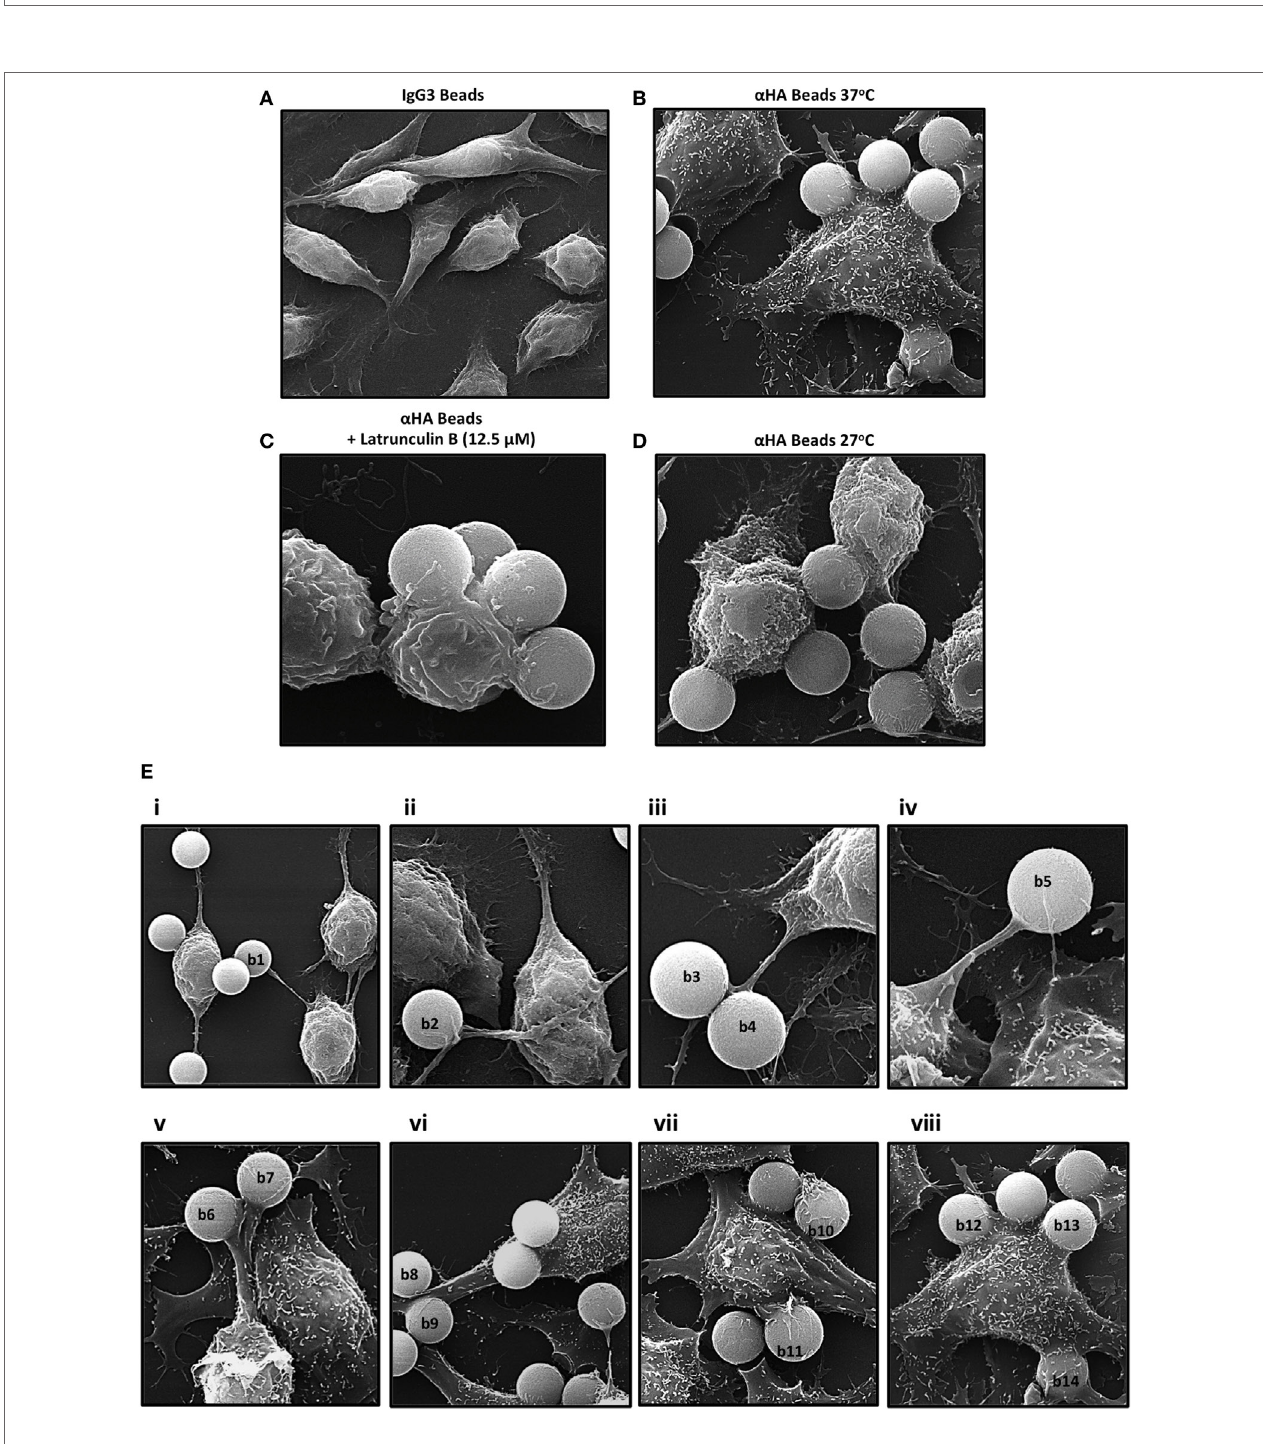
FigUre 3 | Live-cell imaging of IpLITR 2.6b/IpFcR γ -L-mediated phagocytosis at different incubation temperatures. Rat basophilic leukemia-2H3 cells (3 × 10 5 ) stably co-expressing IpLITR 2.6b/IpFcR γ -L and LifeAct-GFP were incubated at 37°C (a) or at 27°C (B) with 9 × 10 5 α HA monoclonal antibody-coated 4.5 µm bright blue microspheres. Immediately after the addition of target beads, images were collected at 10 s intervals for ~8 min using a Zeiss LSM 710 laser scanning confocal microscope (objective 60 × , 1.3 oil plan-Apochromat; Munich, Germany). Representative time-stamps in (a) were extracted from Video S3 in Presentation 2 of Supplementary Material and the time-stamps in (B) were from Video S4 in Presentation 2 of Supplementary Material. In (a) , the target microsphere of interest is indicated with an